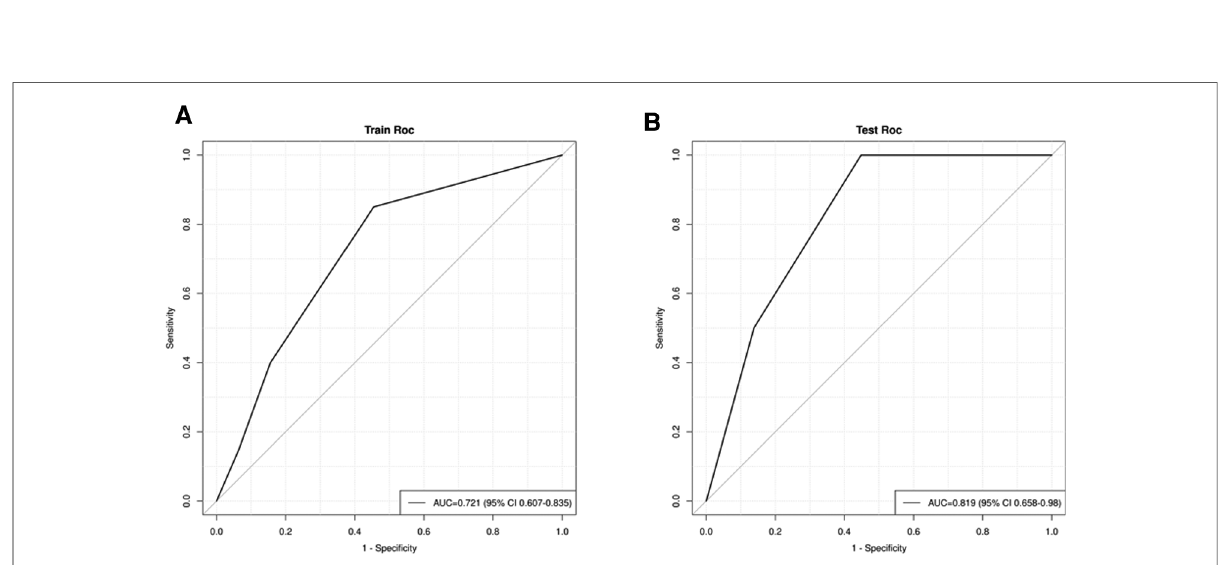
FIGURE 4 ( A ) receiver operating characteristic (ROC) in the training cohort; ( B ) ROC in the validation